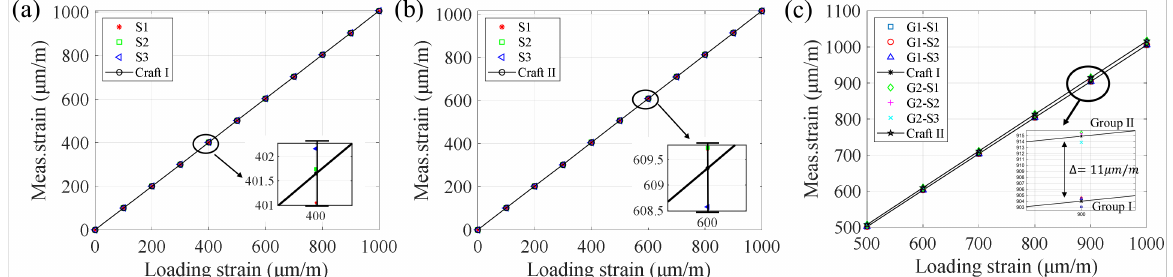
Figure 9. The strain response from two groups of samples to the standard strains. The geometrical parameters of ( a ) Group I and ( b ) Group II are listed in Table 3. ( c ) The parts of ( a , b ) in the range 500–1000 µ m/m are plotted onto the same graph. The strain in the ordinate was measured by the samples, while the strain in the abscissa was calculated by the loading force and the displacements coming from the flexometer.